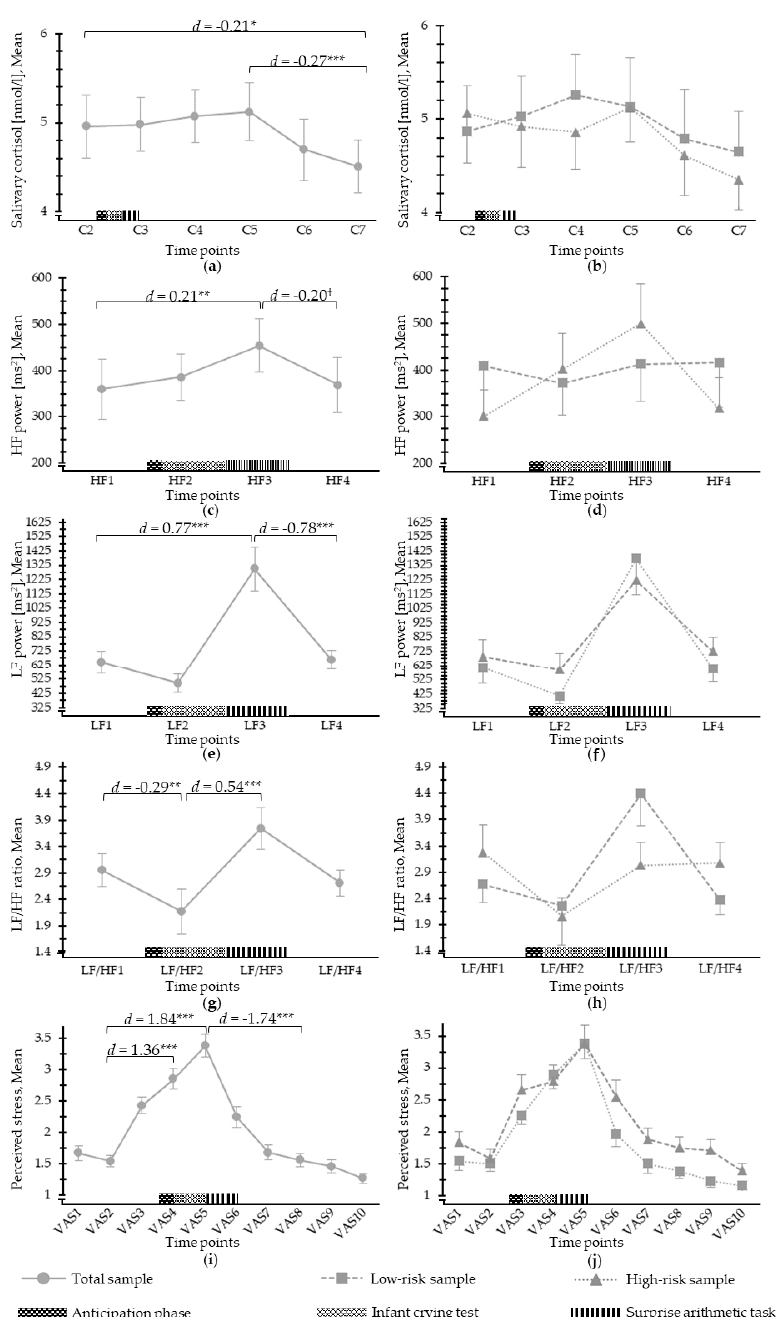
Figure 2. Mean psychophysiological stress reactivity during the different phases of the Lausanne Infant Crying Stress Paradigm: ( a ) mean salivary cortisol for the total sample; ( b ) mean salivary cortisol for the low- and high-risk groups; ( c ) mean HF power (HF, range: 0.15–0.4 ms 2 ) for the total sample; ( d ) mean HF power for the low- and high-risk groups; ( e ) mean LF power (LF, range: 0.04–0.15 ms 2 ) for the total sample; ( f ) mean LF power for the low- and high-risk groups; ( g ) mean LF/HF ratio for the total sample; ( h ) mean LF/HF ratio for the low- and high-risk groups; ( i ) mean perceived stress ratings (range: 1 = not at all to 5 = extremely) for the total sample; ( j ) mean perceived stress for the low- and high-risk groups. Error bars represent standard error. Graphs showing mean group stress response patterns over time are unadjusted and are displayed for illustrative purposes. When controlling for the perceived infant life threat, significant or marginal group effects on salivary cortisol release ( d = 0.53 *), HF power ( d = 0.53 † ), LF/HF ratio ( d = 0.93 ***), and perceived stress ( d = 0.91 ***) emerged that are not indicated in this figure. † p < 0.10, * p < 0.05, ** p < 0.01, *** p <